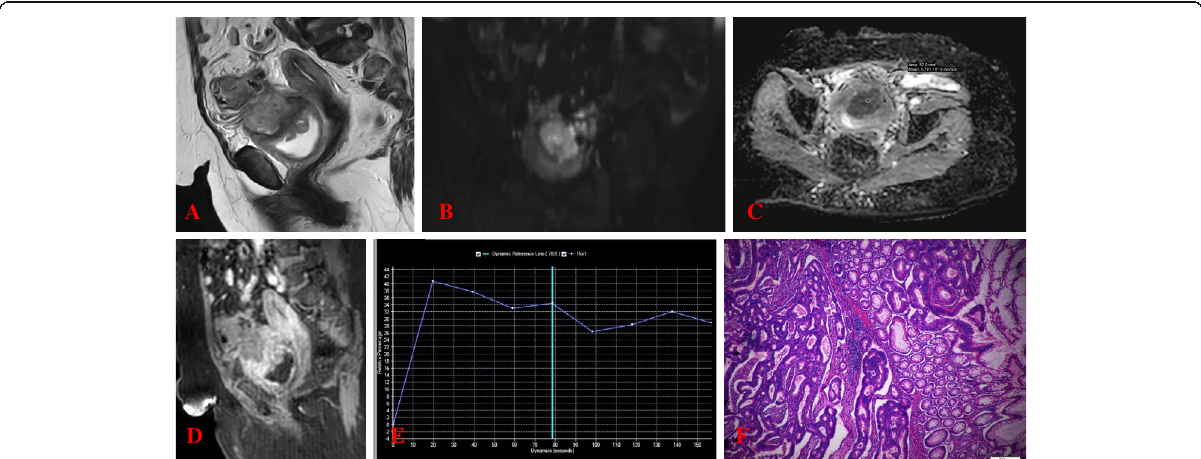
Fig. 7 A 69-year-old female patient presented with history of recurrent hematuria and burning micturition and notable changes of bowel habit with episodes of constipation alternating with diarrhea as well as bloody stool. Sagittal T2 WI ( a ) showed an intra-vesical soft tissue mass arising from bladder dome and high anterior wall expressing heterogeneous signal intensity with infiltration of the perivesical fat, anterior peritoneal reflection, and sigmoid colon. Coronal DW-MRI (b1000) ( b ) showed restricted diffusion of the masses with intact underlying low SI muscle layer. Axial ADC map ( c ) showed low SI of the lesion with ADC value = 0.79 × 10 – 3 mm 2 /s, consistent with high-grade tumor. Axial post contrast T1WI FAT-SAT ( d ) showed heterogeneous enhancement of the mass which infiltrated the sigmoid colon with areas of cystic degeneration. Time- intensity curve ( e ) showed grade 3 curve with early enhancement and rapid washout. Multiparametric MRI features suggest high-grade stage T4a urinary bladder carcinoma. Microscopic image of histopathology ( f ) high-grade adenocarcinoma carcinoma which confirm the multiparametric MRI